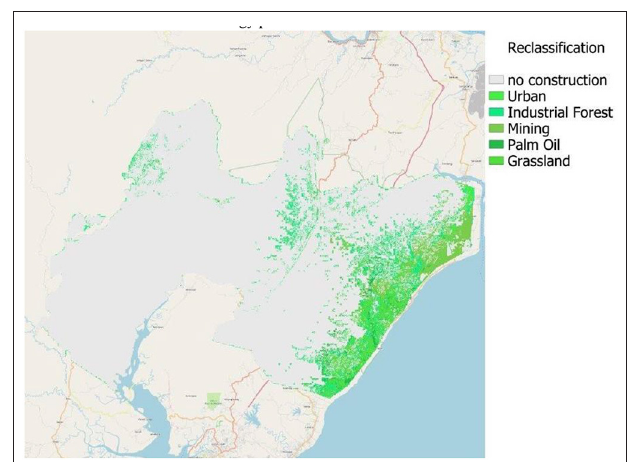
FIGURE 9 | Global horizontal